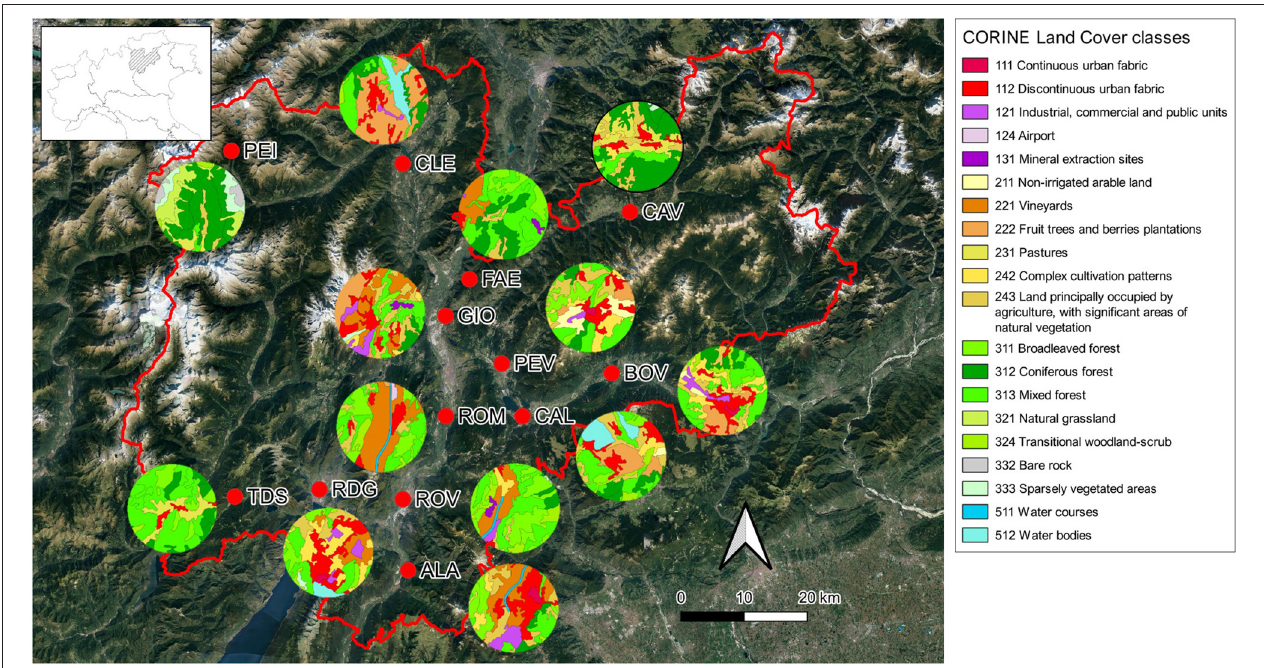
FIGURE 1 | Map of the 13 sampling locations, also showing the landscape composition at 3km radius buffers around the sampling locations using CORINE Land Cover classes. Location acronyms are ALA (Ala), BOV (Borgo Valsugana), CAL (Caldonazzo), CAV (Cavalese), CLE (Cles), FAE (Faedo), GIO (Giovo), PEI (Peio), PEV (Pergine Valsugana), RDG (Riva del Garda), ROM (Romagnano), ROV (Rovereto), and TDS (Tiarno di Sopra). See Supplementary Table 1 for additional information on sampling